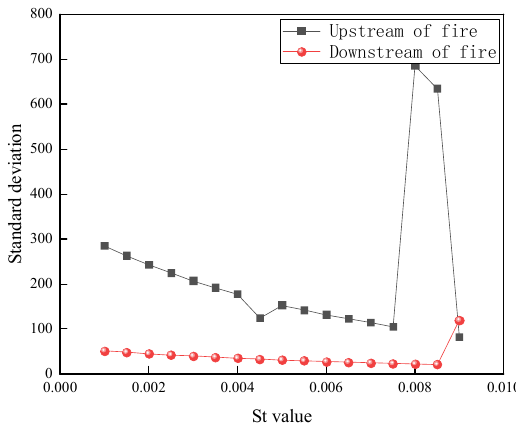
FDS simulation results St=0.0085 calculation results of temperature attenuation